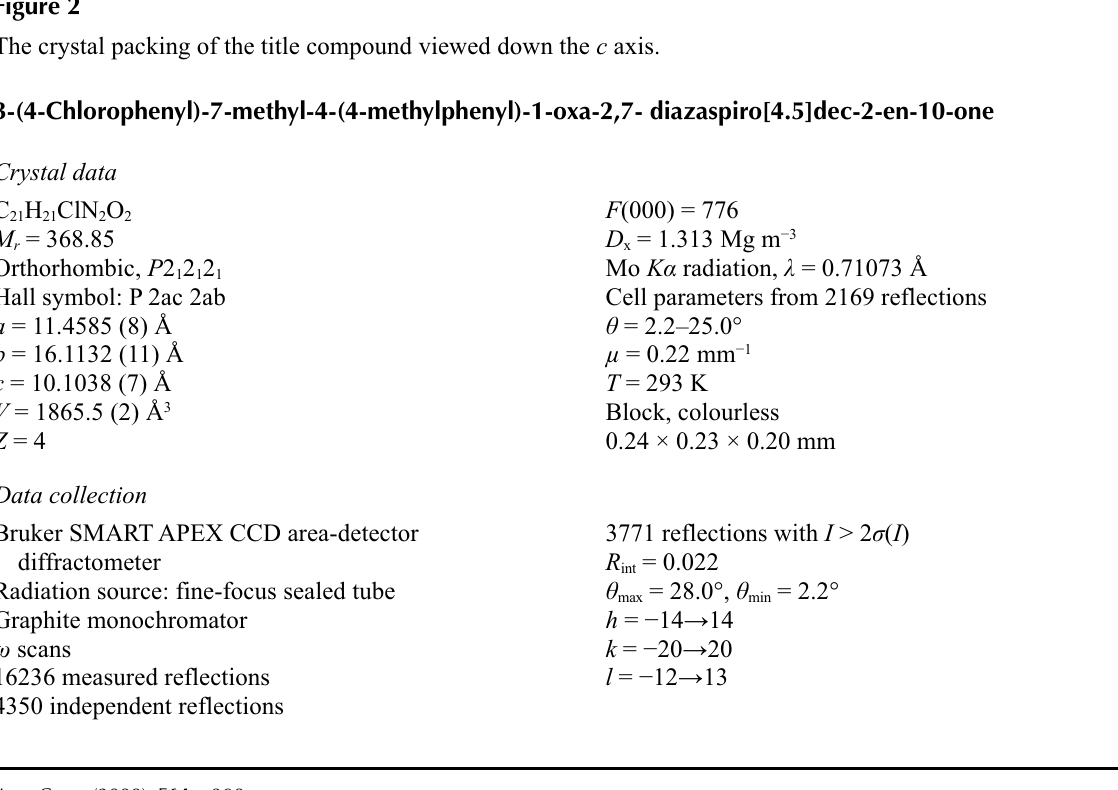
The crystal packing of the title compound viewed down the c